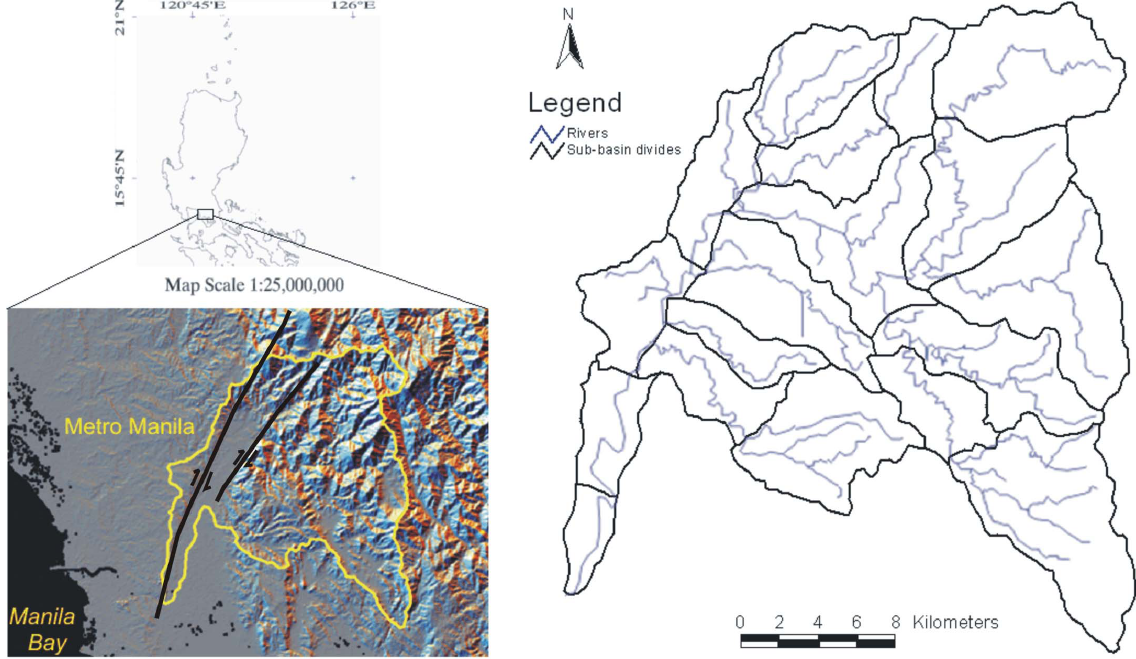
Fig. 1. The Marikina River Basin transverse by the East and West Marikina Valley Faults (black lines).